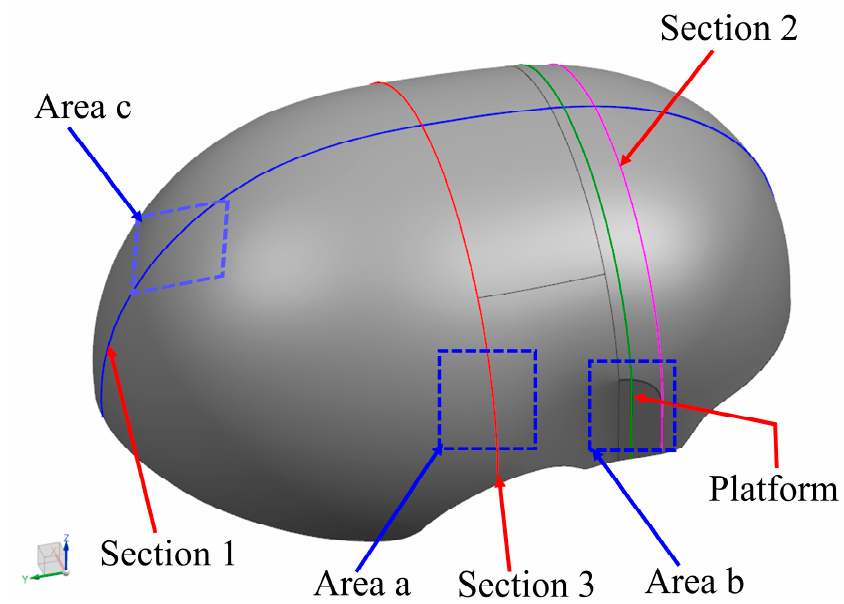
Figure 2. Location of CT measurement